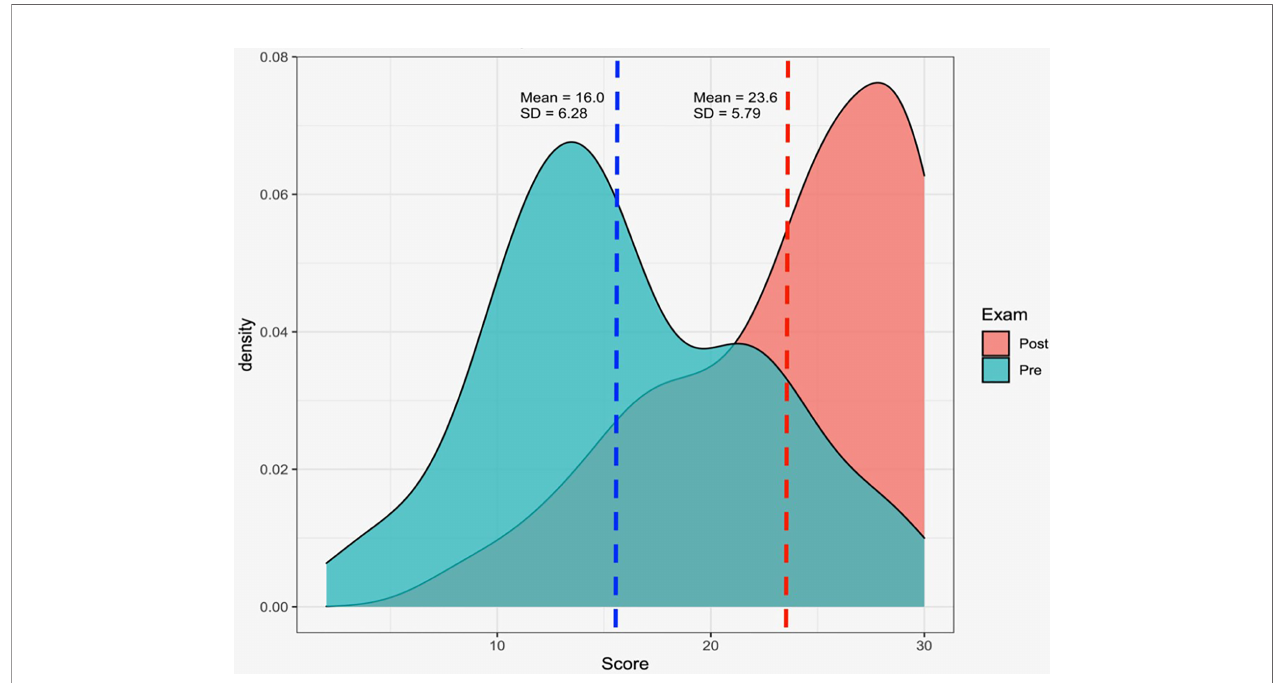
FIGURE 1 | Scoring tendencies for pre- and post-curriculum test. Pre- and post-curriculum raw scoring, showing a clear trend towards improved exam scoring after longitudinal